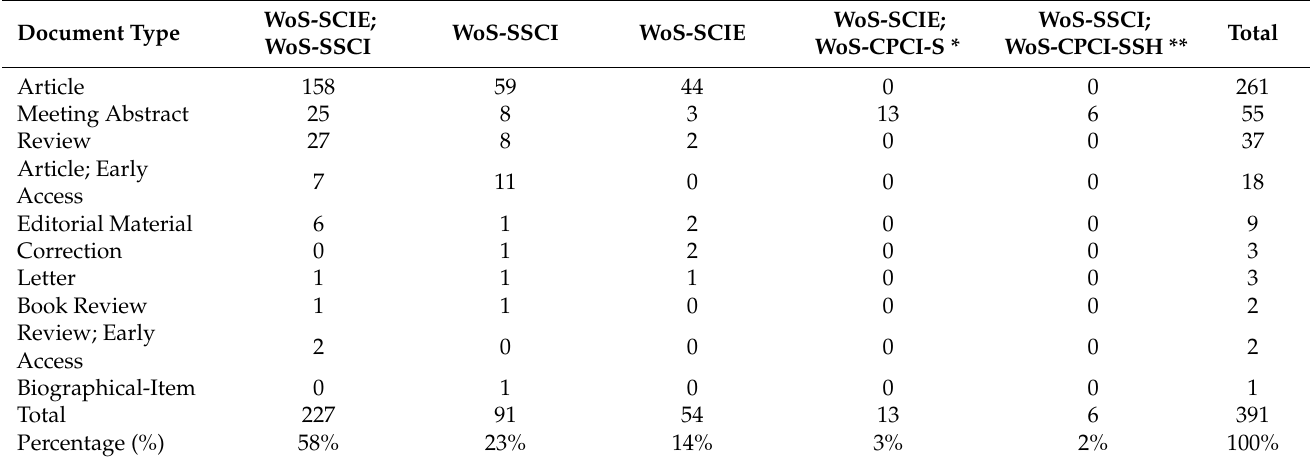
Table 1. Extracted document types by WoS index databases.